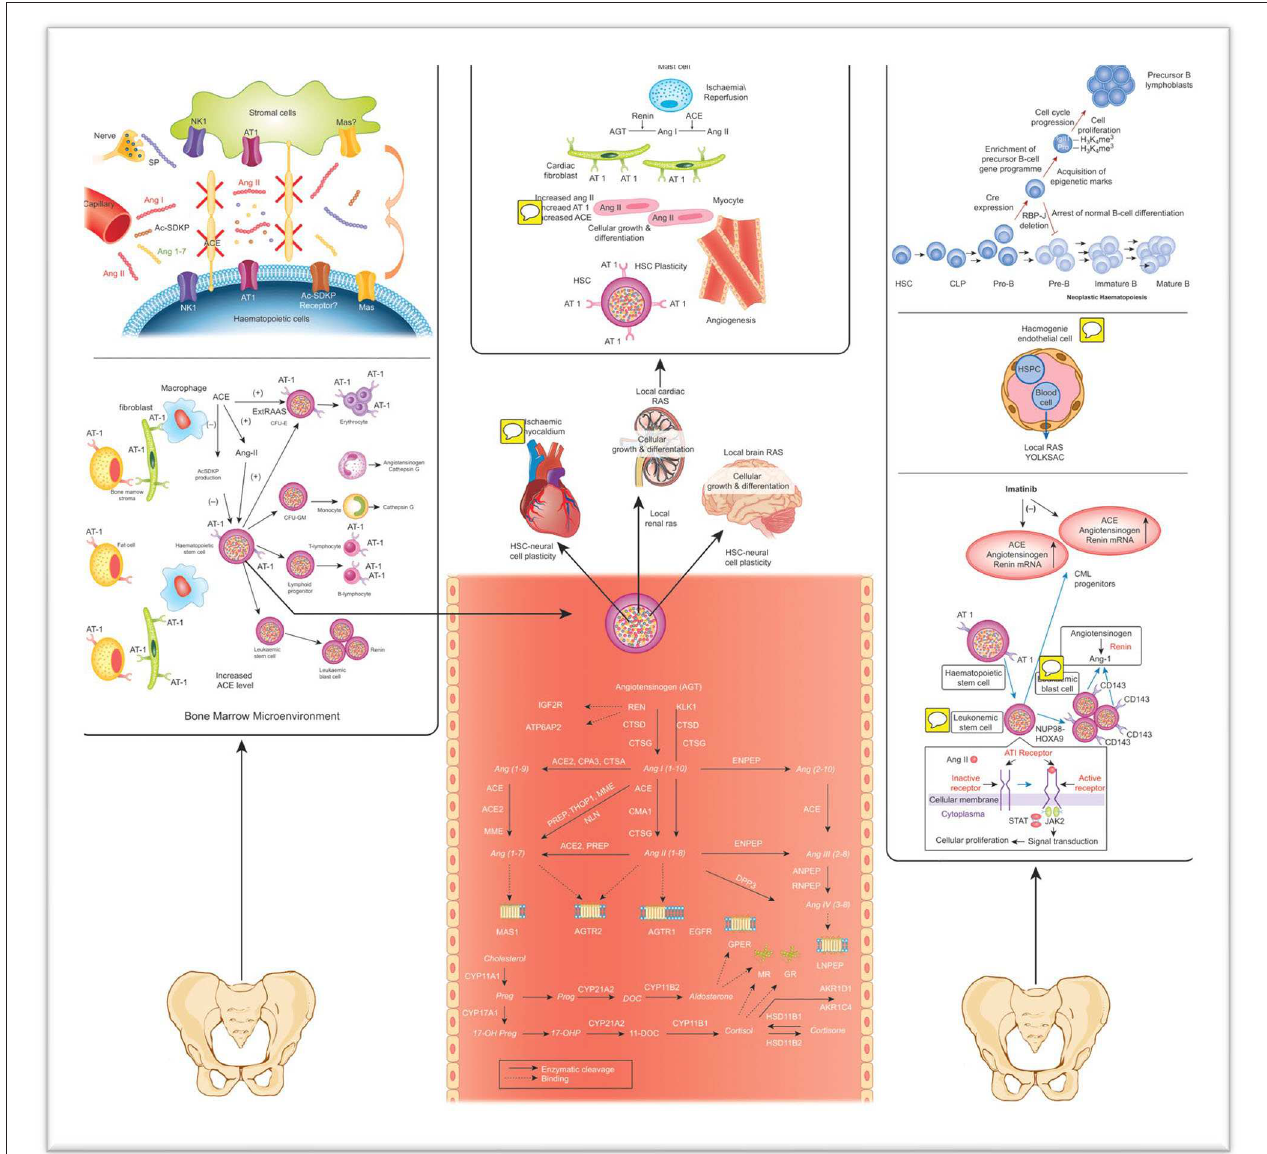
FIGURE 1 | The effect of local RAS on normal and leukemic hematopoiesis, as well as plasticity and systemic circulation, are shown (19). Ang I, Ang II, Ac-SDKP, and Ang 1-7 are secreted in different tissues and transferred to the BM through circulation. SP is secreted from the nerve end protruding into the BM. ACE converts Ang II from Ang I and reduces bioactive SP, Ac-SDKP and Ang 1-7 (38). Mas, with the Ang 1-7 receptor, is detected in the BM. Peptides in RAS can stimulate hematopoietic cells (39). Furthermore, local BM RAS has a function in the development, formation, proliferation, and differentiation of hematopoietic progenitors. Angiotensin peptides and steroid hormones were symbolized in gray. Lymphoid cells cannot differentiate throughout the normal B-cell pathway (40). Therefore, the leader B-cell gene undergoes epigenetic initiation and enrichment of a precursor B-cell gene programme. As a result, cell cycle progression and cell proliferation are observed in mutant cells. This leads to the enlargement of a lymphoblast population and the development of leading B cell leukemia (5, 19, 23, 38, 40, 41). HSPC, Hematopoietic stem/progenitor cells; ACE, Angiotensin converting enzyme; CML, Chronic myeloid leukemia; Ang, Angiotensinogen; CFU-GM/E, Colonyforming units-Granulocyte-Macrophage/erythroid; JAS/STAT, Janus kinase/Signal transduction and transcription; BC, Blood cell; Ang, Angiotensin; Preg, Pregnanolone; Prog, Progesterone; DOC, deoxycortisol; 17-OHP, 17-OH Progesterone; ACE, angiotensin I converting enzyme; ACE2, angiotensin I converting enzyme type 2; AGTR1, angiotensin II type 1 receptor; AGTR2, angiotensin II type 2 receptor; AKRIC4, aldo-ketoreductase family 1 member C4; AKRID1, aldo-ketoreductase family 1 member D1; ANPEP, alanyl-aminopeptidase; ATP6AP2, prorenin/renin receptor; CMA1, chymase 1; CPA3, carboxypeptidase A3; CTSA, cathepsin A; CTSD, cathepsin D; CTSG, cathepsin G; CYP11A1, cytochrome P450 family 11 subfamily A polypeptide 1; CYP11B1, cortisolsynthase; CYP11B2, aldosteronesynthase; CYP17A1, cytochrome P450 family 17 subfamily A polypeptide 1; CYP21A2, cytochrome P450 enzyme family 21 subfamily A polypeptide 2; DPP3, dipeptidyl-peptidase 3; ENPEP, glutamylaminopeptidase (aminopeptidase A); GR, glucocorticoidreceptor; HSD11B1, hydroxysteroid (11-beta) dehydrogenase 1; HSD11B2, hydroxysteroid (11-beta) dehydrogenase 2; IGF2R, insulin-like growth factor 2 receptor; KLK1, tissuekallikrein; LNPEP, leucyl/cystinylaminopeptidase; MAS1, MAS1 proto-oncogene; MME, membranemetallo-endopeptidase; MR, mineralocorticoidreceptor; NLN, neurolysin (metallopeptidase M3 family); PREP, prolylendopeptidase; REN, renin; RNPEP, arginylaminopeptidase (aminopeptidase B); THOP1, thimetoligopeptidase 1. Images of IGF2R36, ATP6AP237, MR38, GR39, G-protein coupled receptors (AGTR1, AGTR2, GPER, and MAS1) 40 and LNPEP41 ( 19).